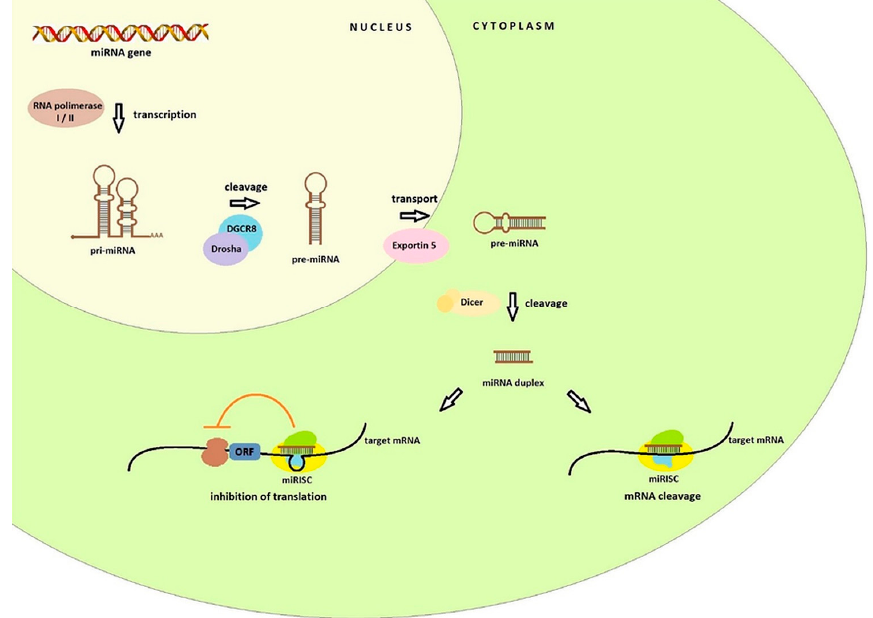
Figure 1. Pathway of miRNA biogenesis. In the nucleus RNA polymerase I or II synthesizes primary miRNA. Then, pri-miRNA are processed into pre-miRNA hairpins by the Drosha DGCR8 microprocessor. Pre-miRNA is exported into the cytoplasm by the transport protein Exportin 5. In the next step, the Dicer endonuclease create a miRNA duplex. The mature miRNA guides the RISC to target mRNA to inhibit the translation.